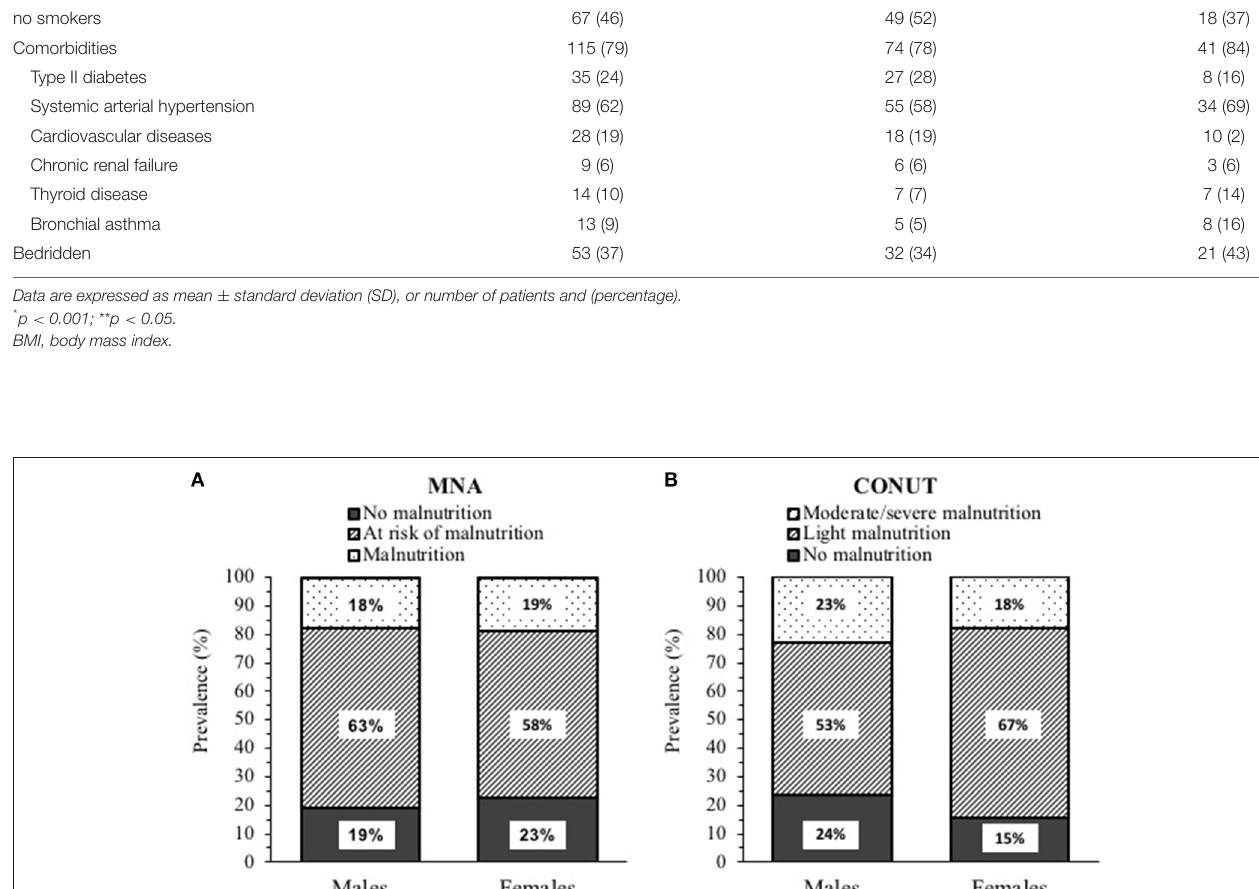
Frontiers in Nutrition |